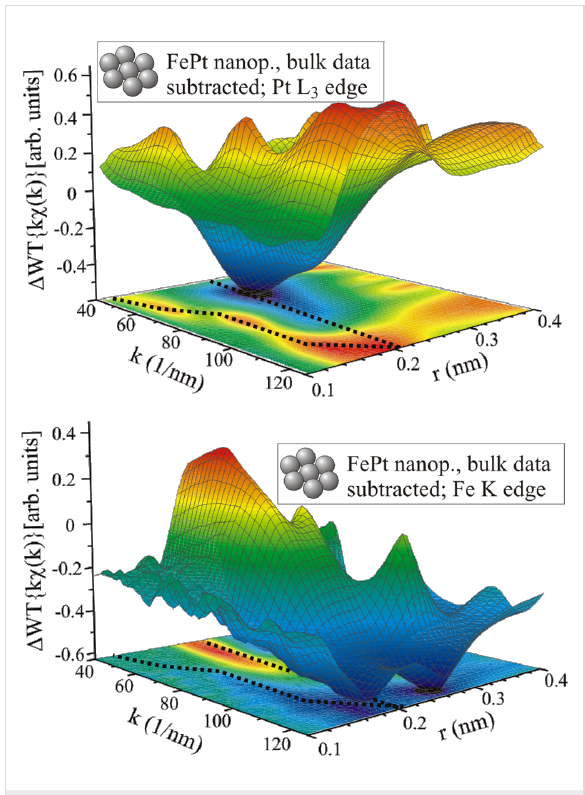
Figure 7: WT of room temperature EXAFS data of FePt nanoparticles measured at the Pt L 3 (upper graphic) and Fe K absorption edge (lower graphic) after subtraction of the WT of the corresponding bulk data [68].